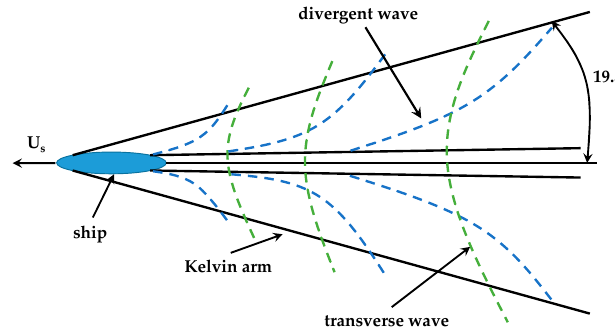
Figure 2. Schematic diagram of Kelvin wake.